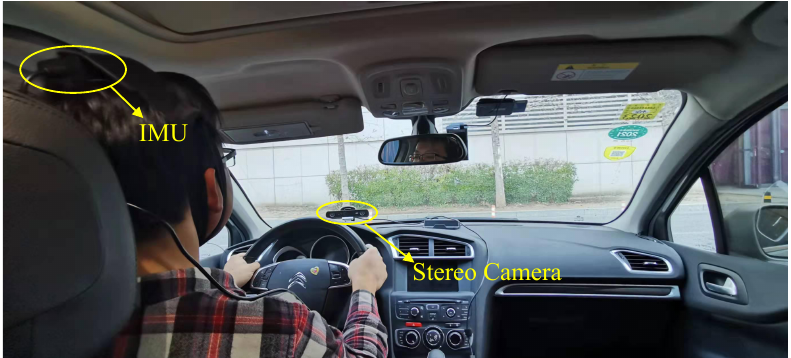
Figure 4. Setup of data acquisition in the real driving environment.